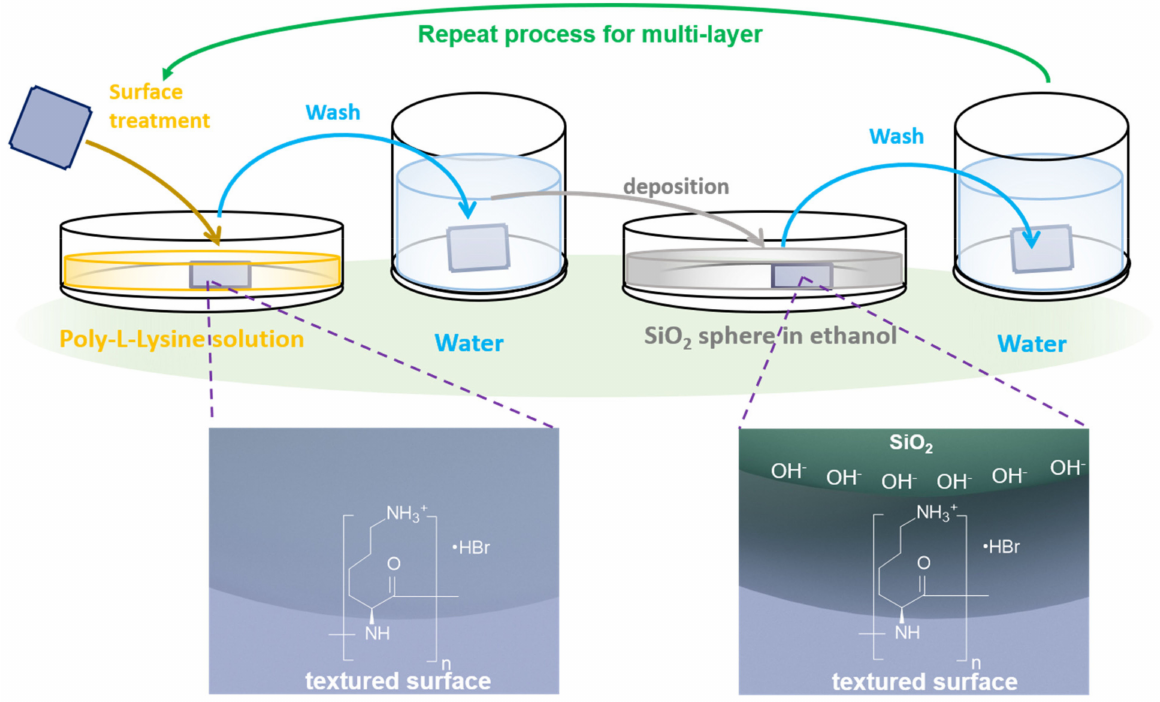
Figure 1. Schematic illustration and self-assembly process. The four-step self-assembly procedure of SiO 2 nanosphere onto the textured 3D surface, and the inset figures show the electrostatic force-directed assembly